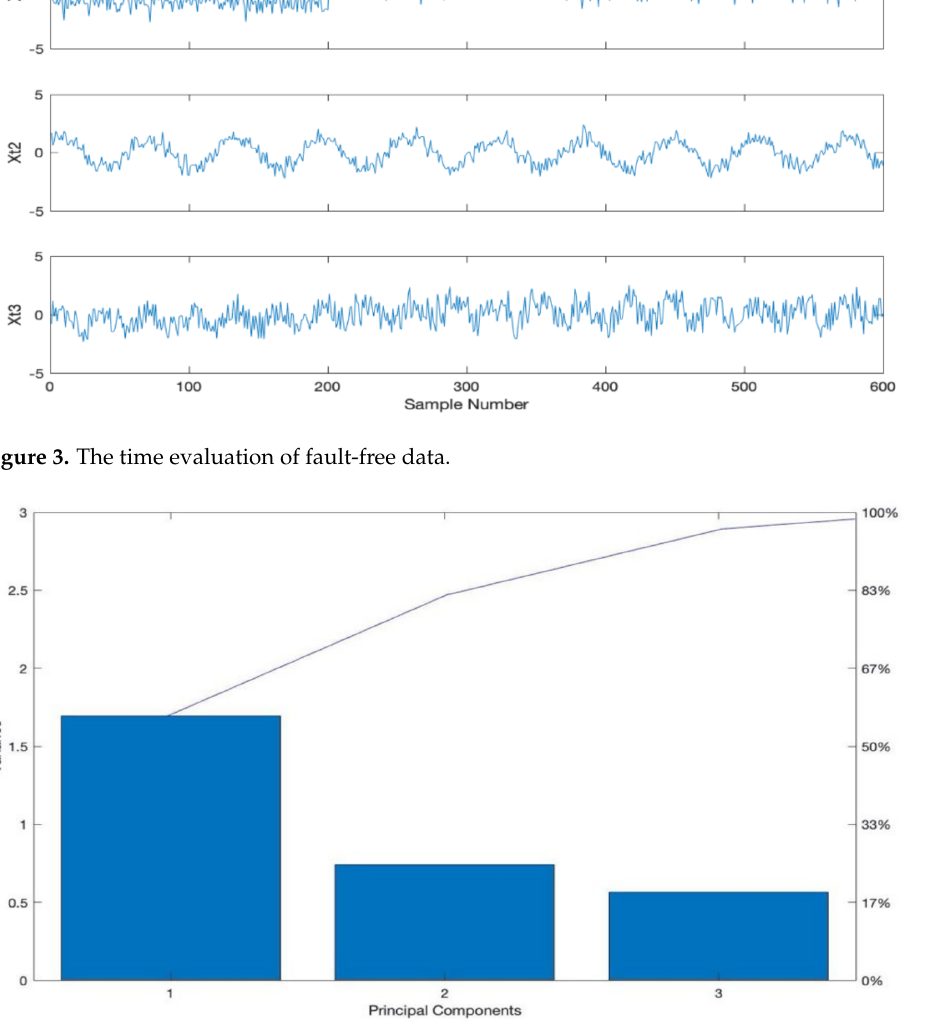
Figure 4. Variance gained by each principal